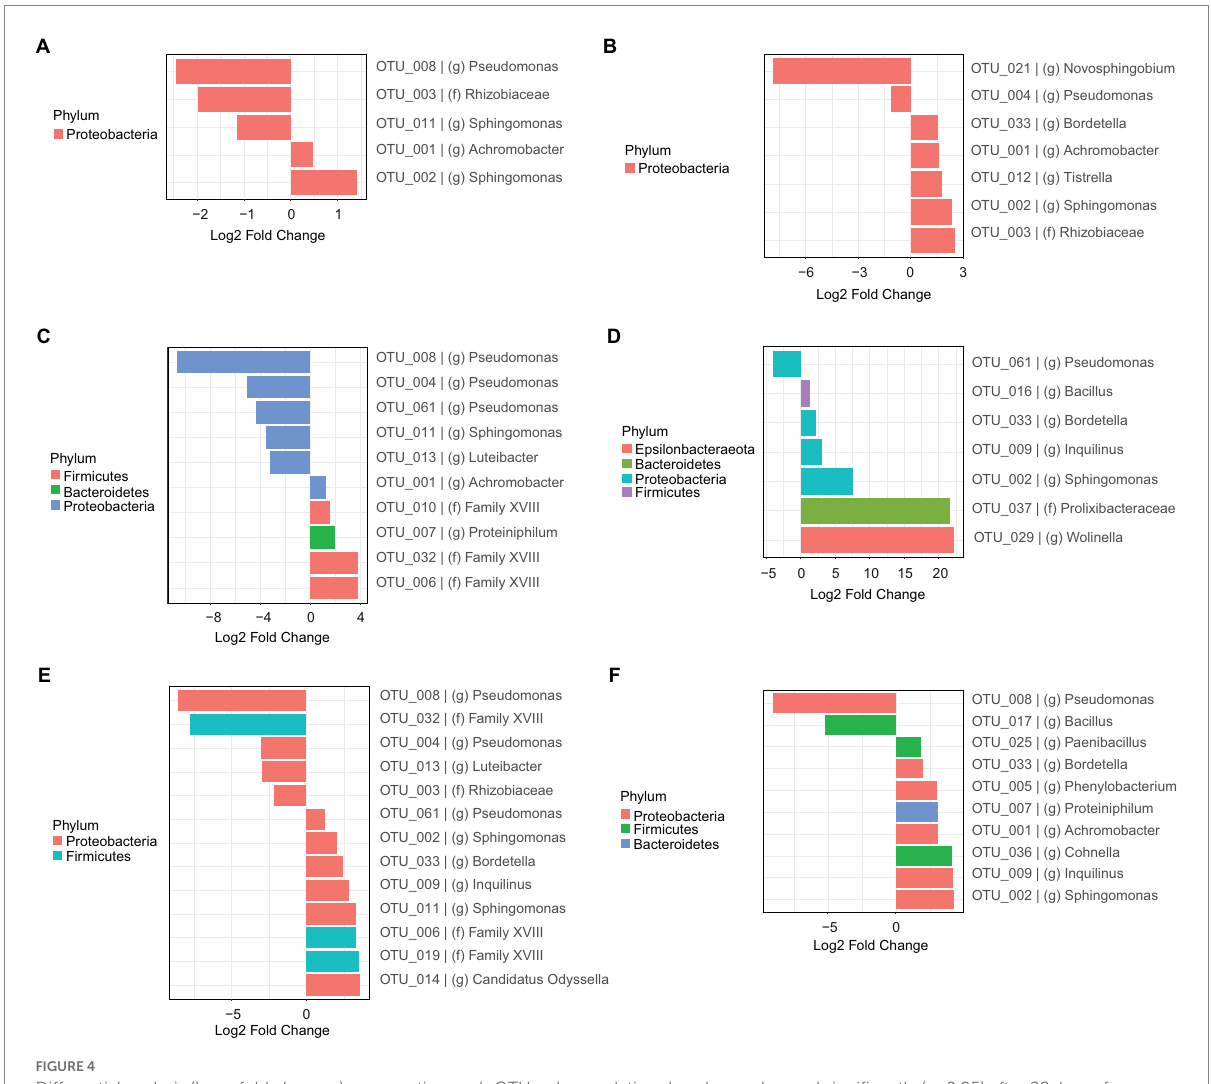
FIGURE 4 Differential analysis (Log 2 -fold changes) representing each OTUs whose relative abundance changed significantly ( p < 0.05) after 28 days of incubation in comparison with the original inoculum (0 day) from cultures in BS medium during growth on different carbon and energy sources in addition to 7 mM DMSO. (A) , a mixture of 3 aromatic amino acids including 1 mM tryptophan, 1 mM tyrosine and 1 mM phenylalanine; (B) , no additional carbon and energy sources; (C) , 5 mM sodium salicylate; (D) , a mixture of 12 mM sodium acetate and 9 mM sodium lactate; (E) , 1 mM vanillin; (F) , 5 mM vanillin. The bars of the OTUs are coloured according to the colour scale of the phyla that they belong